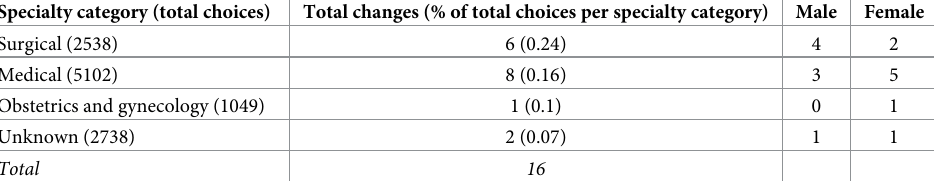
Table 5. Changes in preferences for laboratory and radiology and pathology results per specialty category. Specialty category (total